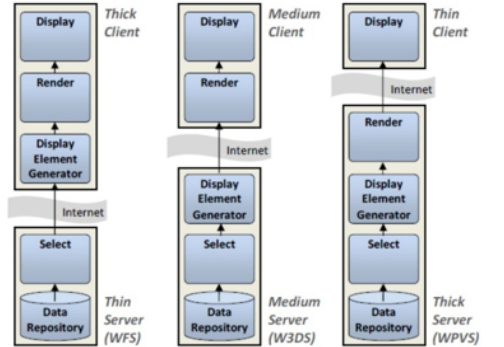
Figure 5 WFS, W3DS and WPVS (deprecated) compared.